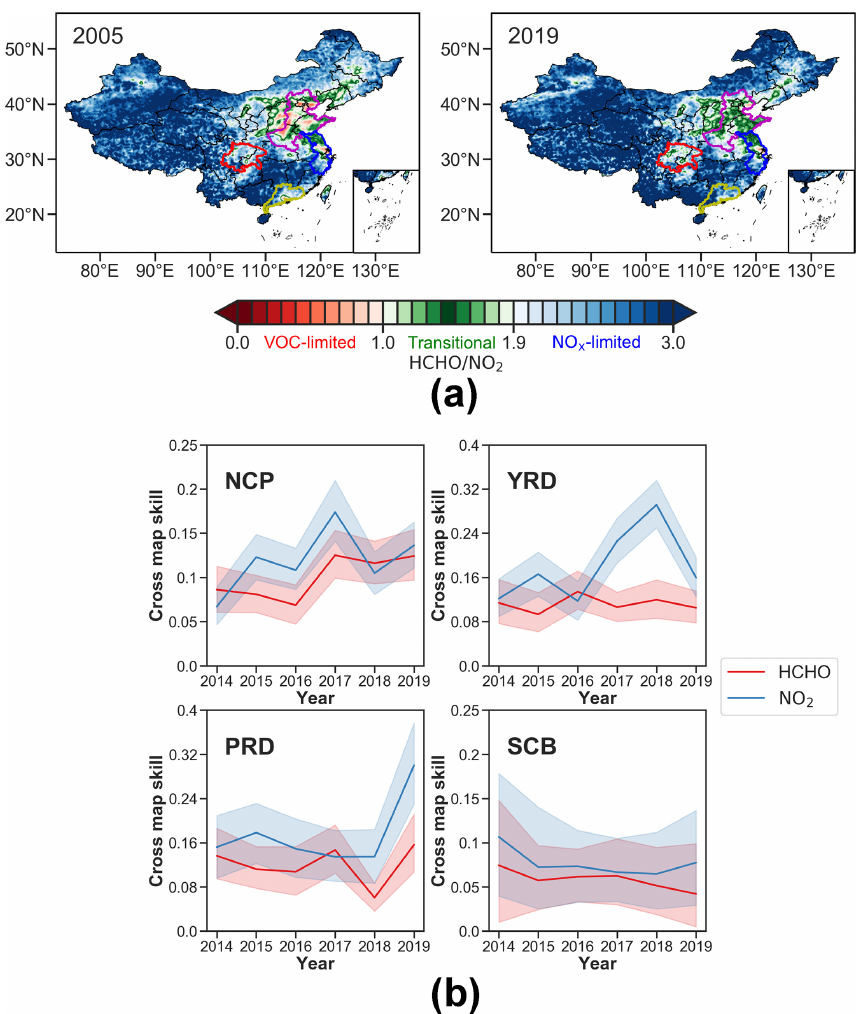
Figure 10. (a) The spatial distribution of HCHO / NO 2 across China in 2005 and 2019. The boundaries of the NCP, YRD, PRD, and SCB are denoted with the purple, blue, yellow, and red bold lines. Red, green, and blue stand for VOC-limited, transitional, and NO x -limited regimes. (b) The annual mean cross-map skill ( ρ value) of four megacity clusters. The red and blue shadow areas indicate the standard deviations.